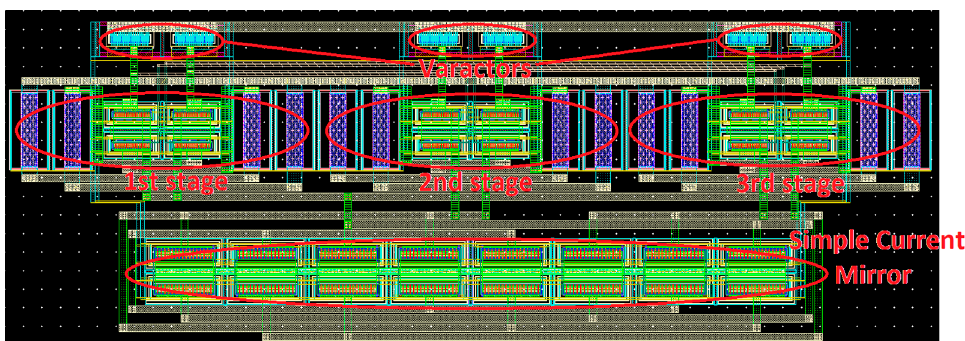
Figure 4. Full custom layout of the RO-VCO based on the CML buffer designed with Cadence Virtuoso [24].